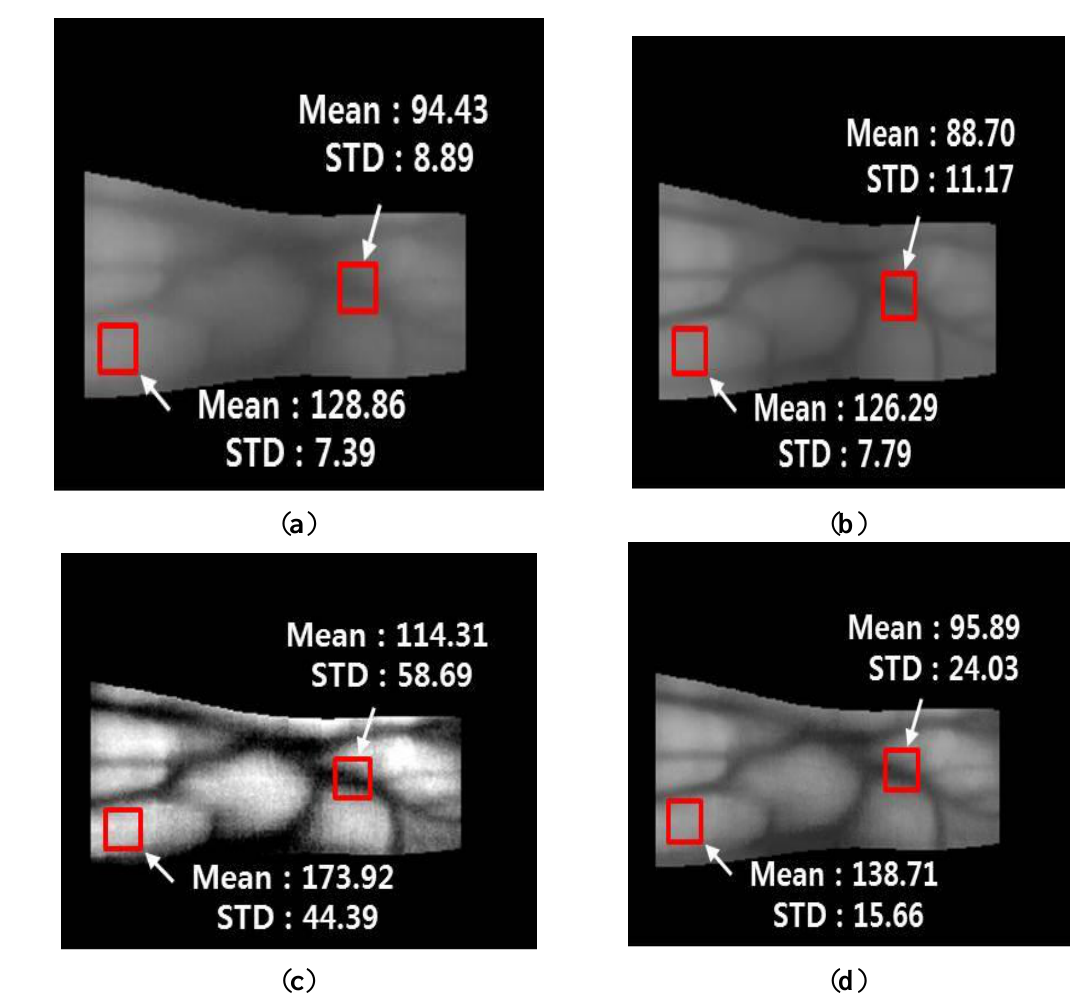
Figure 19. Comparison of the mean and STD values of a vein line and skin region using the proposed method for an image from database II: ( a ) original image of the detected finger boundaries; ( b ) Gabor filtered image; ( c ) Retinex filtered image with a sigma value of 20; and ( d ) image produced using the fuzzy-based fusion method with LOM and the Min rule (proposed